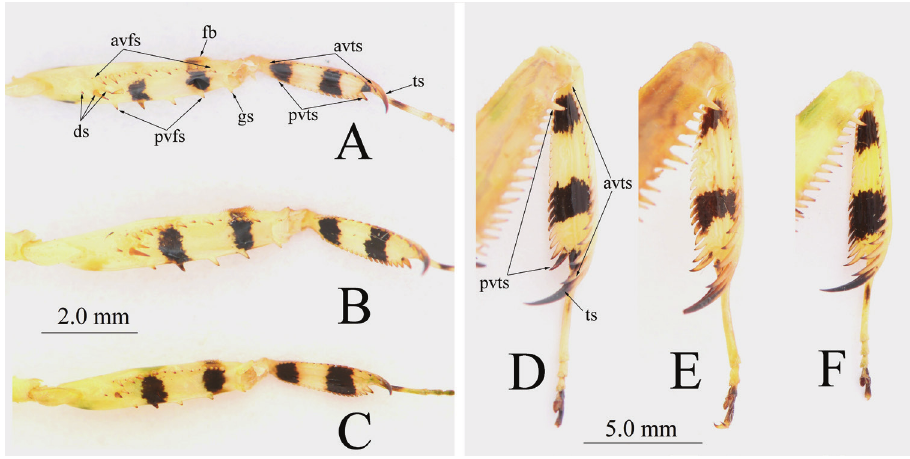
Figure 8. Prothoracic legs of Theopropus spp. A, D T. sinecus sinecus B, E T. xishiae sp. nov. C, F T. sp. A–C male D–F female. Abbreviations: avfs = anteroventral femoral spines; avts = anteroventral tibial spines; ds = discoidal spines; fb = femoral brush; gs = genicular spur; pvfs = posteroventral femoral spines; pvts = posteroventral tibial spines; ts = tibial